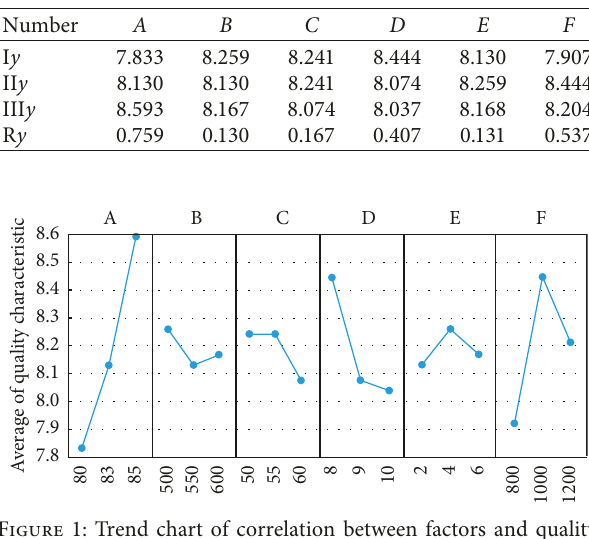
Table 5: Calculation table of range analysis test results.